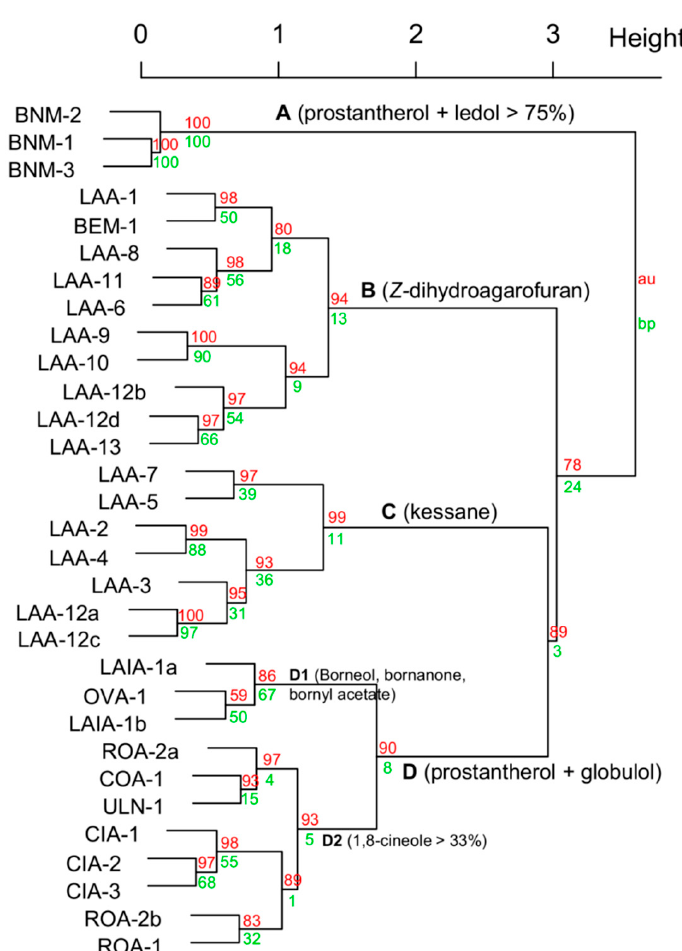
Figure 3. Dendrogram of chemical data of essential oils from species affiliated with P. ovalifolia and P. rotundifolia . BNM = P. sp. Barren Mountain, LAA = P. lanceolata , BEM = P. sp. Blue Mountains, CIA = P. cineolifera , ULN = P. sp. Ulan, COA = P. cotinifolia , OVA = P. ovalifolia (actual), and ROA = P. rotundifolia (actual).